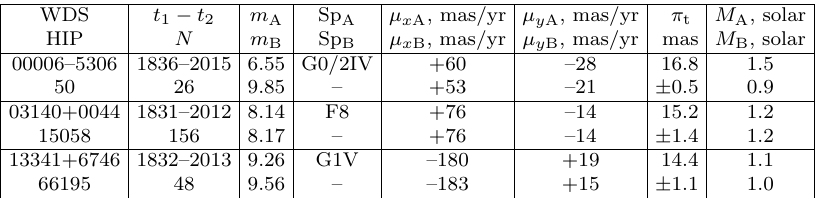
Table 3. Data on the binaries HIP 50, HIP 15058, and HIP 66195.